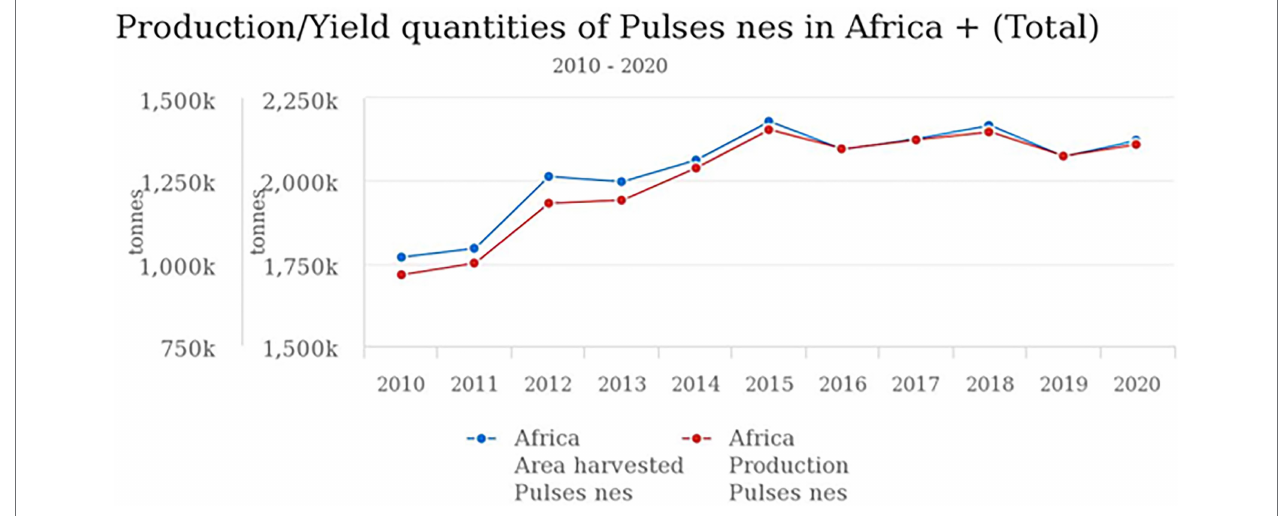
FIGURE 1 | Pulses production/yield quantities in